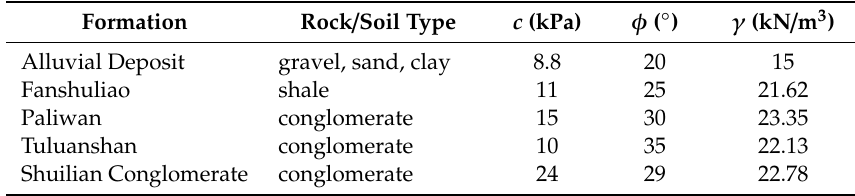
Table 1. Mechanical parameters for distinct formation in study